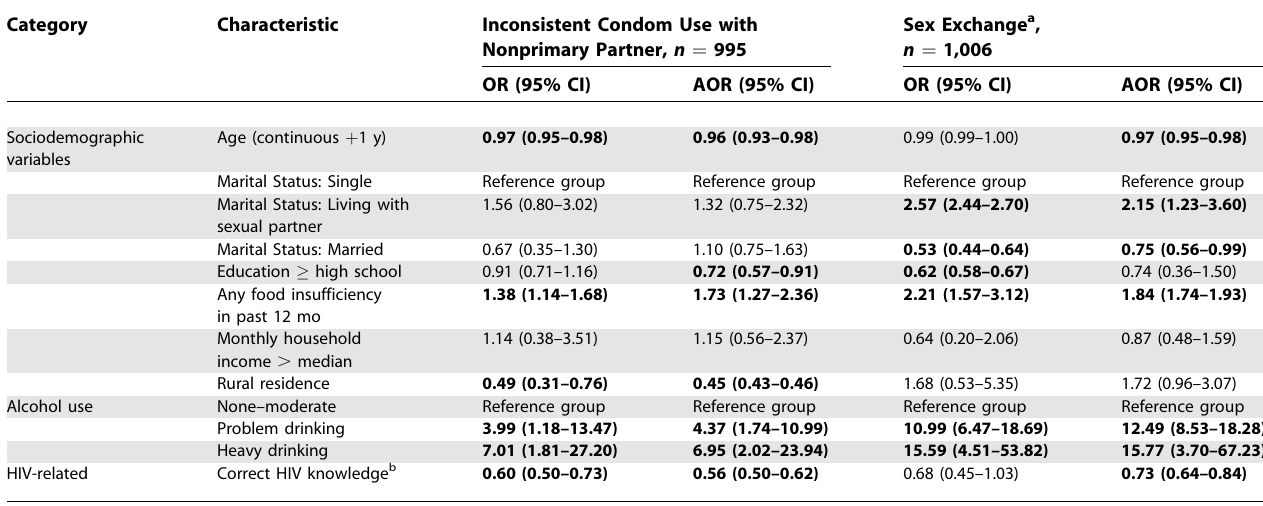
Table 2. Unadjusted and Adjusted Associations with Unprotected Sex and Sex Exchange for Women, Botswana and Swaziland 2004– 2005 Category Characteristic Inconsistent Condom Use with Nonprimary Partner, n ¼